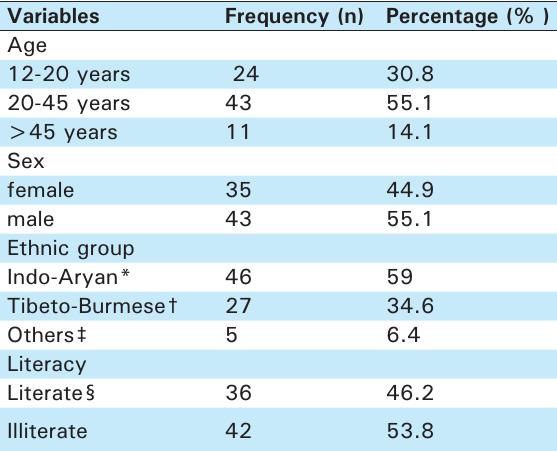
Table 1. Demographic profi le of patients (n=78)